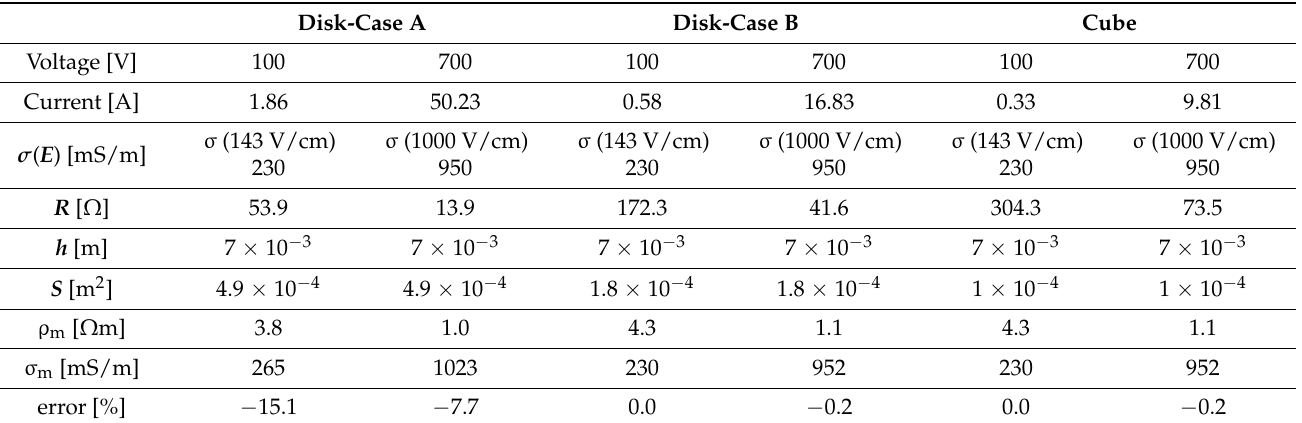
Table 3. Conductivity estimation using the FEA and assessment of the error of estimation for disk and cube-shape model with field-dependent electrical conductivity.